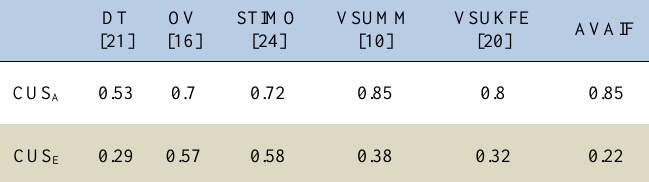
Table 2. Comparing different methods’